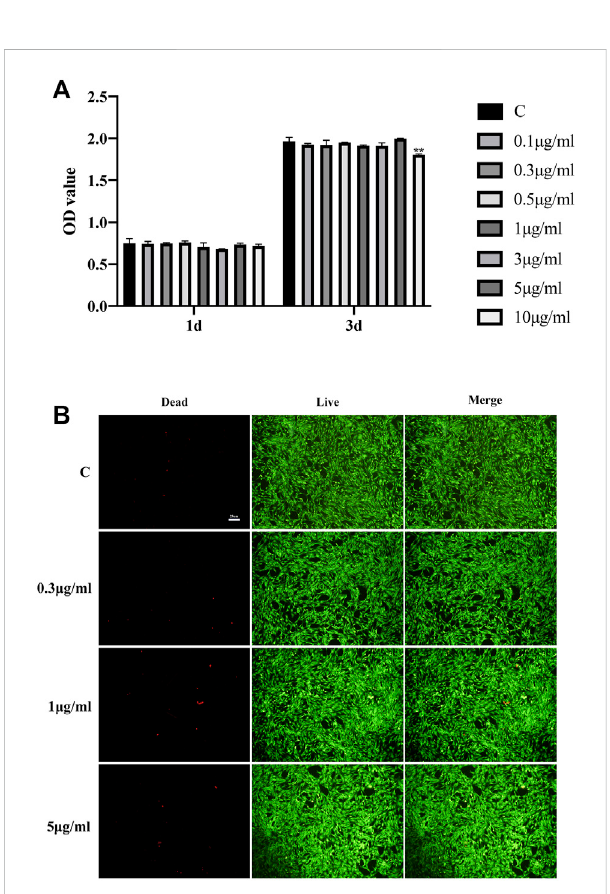
FIGURE 2 Biocompatibility of fullerenol with different concentrations. (A) Opticaldensity (OD)valueofTCstreatedwithdifferent-concentration (0, 0.1, 0.3, 0.5, 1, 3, 5, 10 μ g/mL) fullerenol at 1 and 3 days tested by CCK-8. (B) Live/dead cell staining of TCs treated with 0, 0.3,